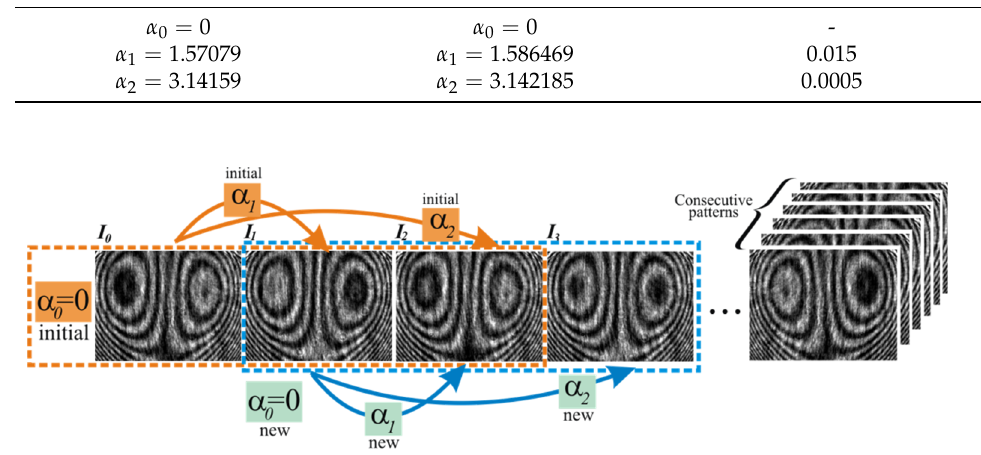
Figure 6. Experimental pattern captures.